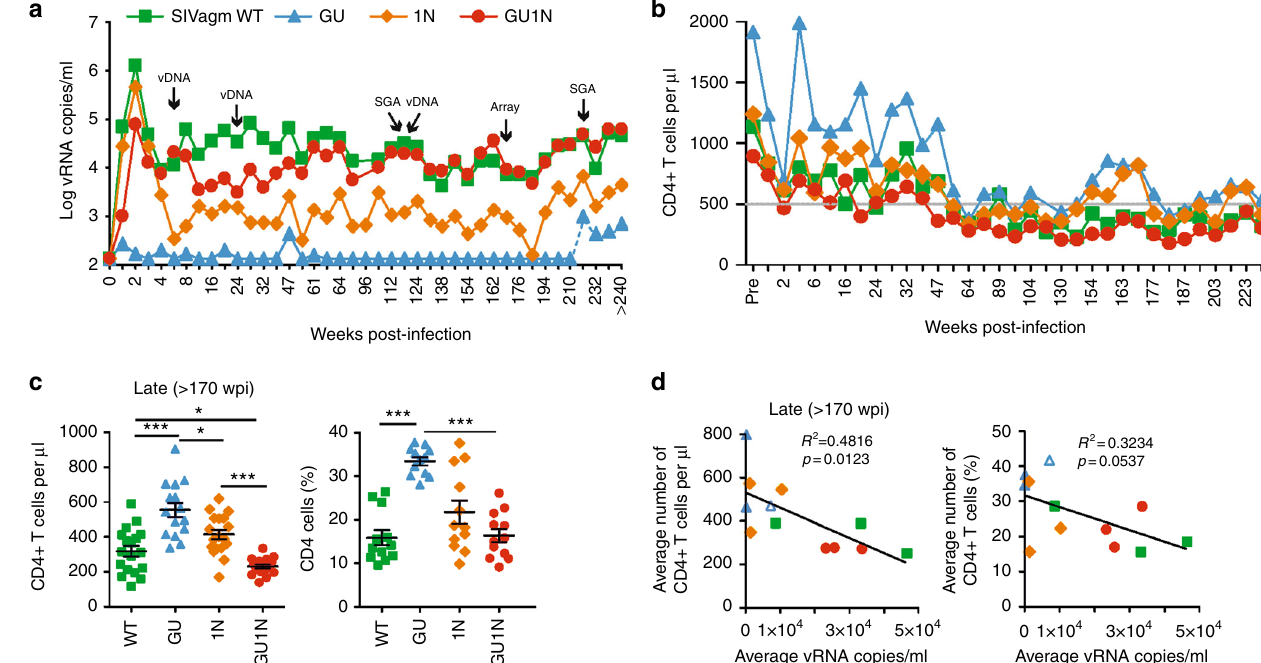
Fig. 2 Replication of HIV-1-like SIVagm constructs in vivo. a Mean levels of plasma viremia in AGMs infected with the indicated SIVagm constructs. Three animals were infected with each virus and plasma RNA loads were determined as described in the Methods section. Arrows indicate time points used for single genome viral RNA analysis (SGA), determination of proviral copy numbers (vDNA), or microarray analysis (Array). Symbols refer to all panels. The limit of viral RNA detection is ~100 copies/ml of plasma. b Absolute mean CD4 + T cell counts in AGMs infected with the WT, GU, 1N, and GU1N SIVagm constructs. The prevalue (Pre) represents the average CD4 + T cell count of four measurements prior to infection. c Absolute numbers and percentages of CD4 + T cells at later time points of infection (>170 wpi) with mean ± SEM. Each symbol represents one measurement. d Correlation between the average vRNA loads and CD4 + T cell counts (left) and percentages (right) in the fi nal year of follow-up. Each symbol corresponds to one AGM and represents the average value of nine measurements from 171 to 240 wpi. The open triangle represents AGM14627 that was accidentally infected. p -values were calculated using the two-tailed unpaired Student's- t -test and signi fi cant differences are indicated as: * p < 0.05; ** p < 0.01; *** p <